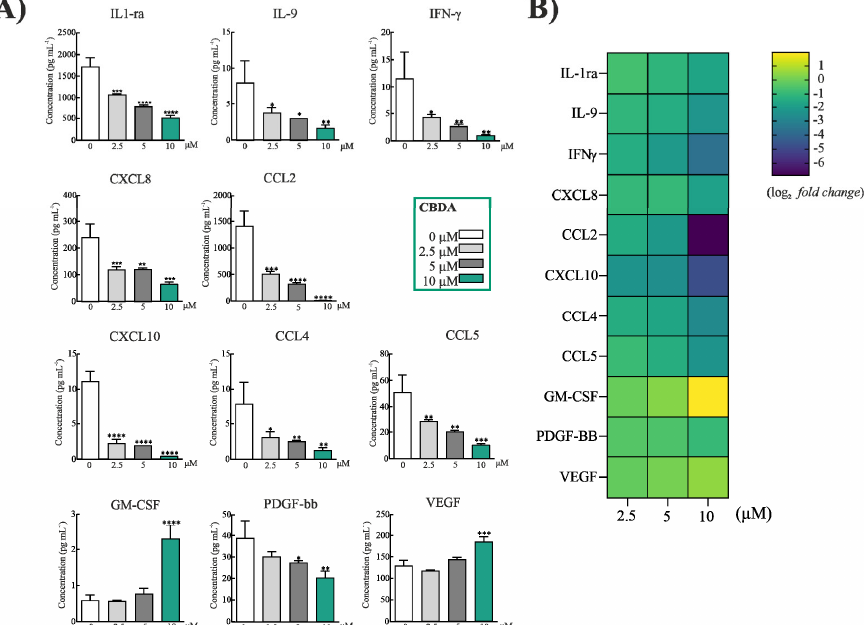
Figure 3. ( A ) Cytokines and chemokines profile in HaCaT cells treated with CBDA 2.5, 5 and 10 μM, and in untreated cells serving as control. Statistical analysis was performed using Graphpad Prism 8 software (Graphpad Software, La Jolla, CA, USA). The results were statistically analyzed using one-way ANOVA test followed by Dunnett’s Multiple Comparison Test. (*) p < 0.05; (**) p ≤ 0.01; (***) p ≤ 0.001 and (****) p ≤ 0.0001 indicate a statistically significant difference with controls. ( B ) Heatmap showing the log 2 fold change of differentially expressed cytokines in culture media of HaCaT cells after treatment with CBDA. Color codes in each panel refer to blue for lower expression (down-regulation) and yellow for higher expression (up-regulation) levels. Table 1. Antimicrobial activities of CBDA against ATCC strains. a MIC, minimum inhibitory concen- tration values are expressed as concentration of CBDA. b MBC, minimum bactericidal concentration values are expressed as concentration of